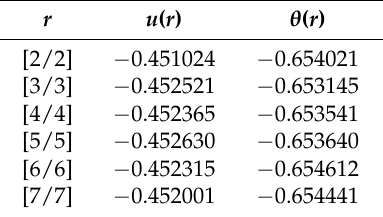
Table 2. The homotopy-pade approximation of u ( r ) and θ ( r ) for β = 0.4, δ = 2, K = 0.2, M =